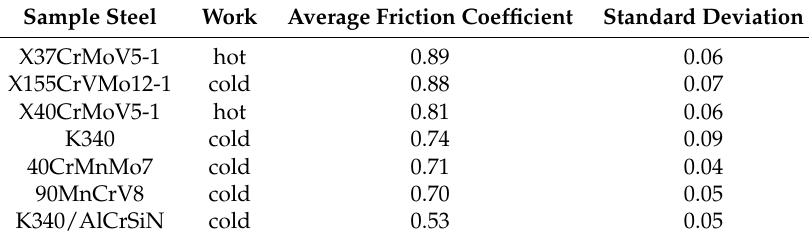
Table 6. Friction coefficients of the tested